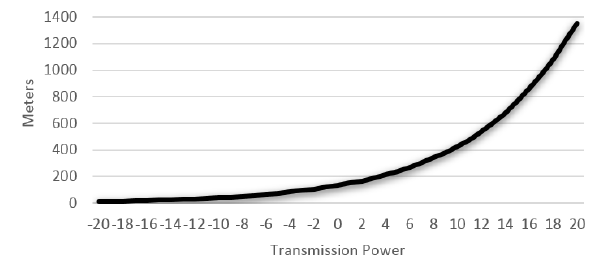
Figure 5. Live output as the simulation